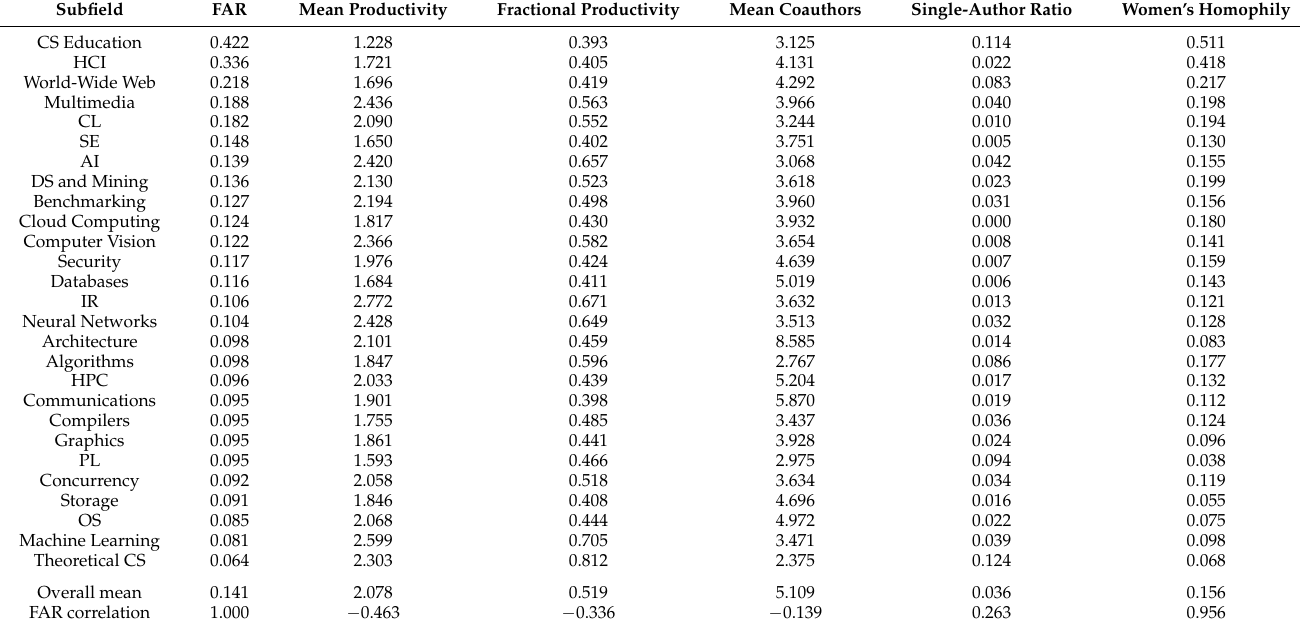
Table 4. Comparison of subfields by different gender metrics, ordered by FAR. Metrics include mean productivity (papers per author), fractional paper total, mean total coauthors (with repeats), ratio of papers written by a single author, and the ratio between a woman’s probability to coauthor with a woman and